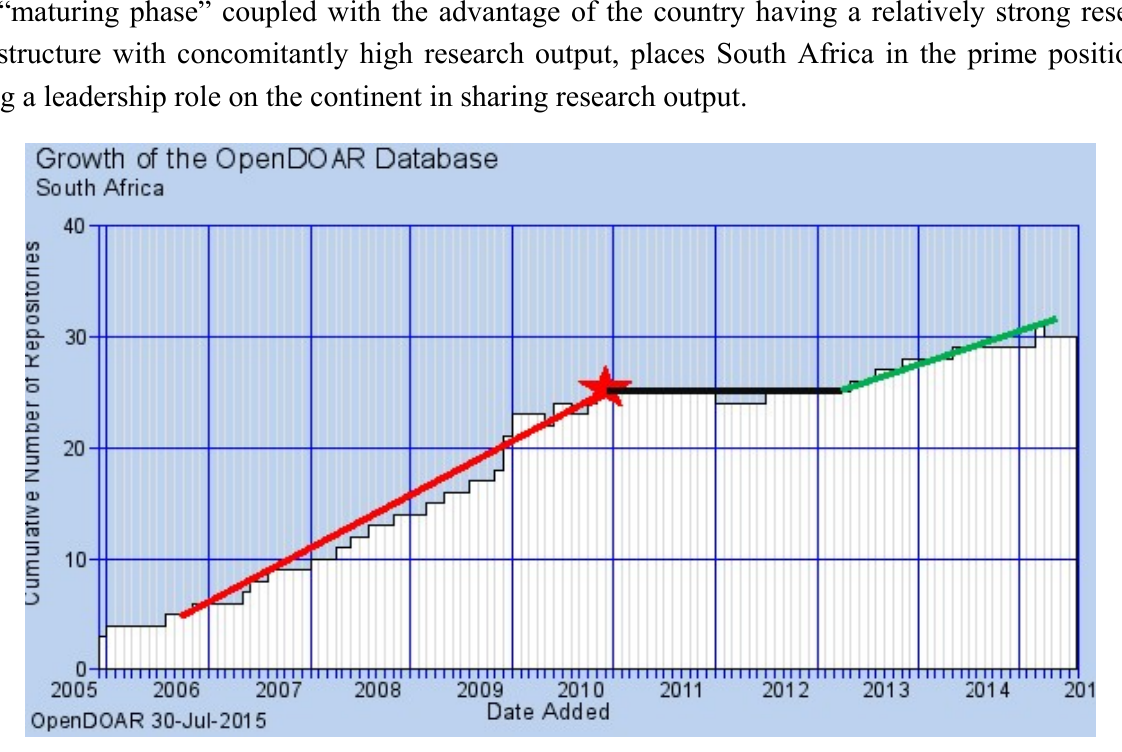
Figure 2. Growth of institutional